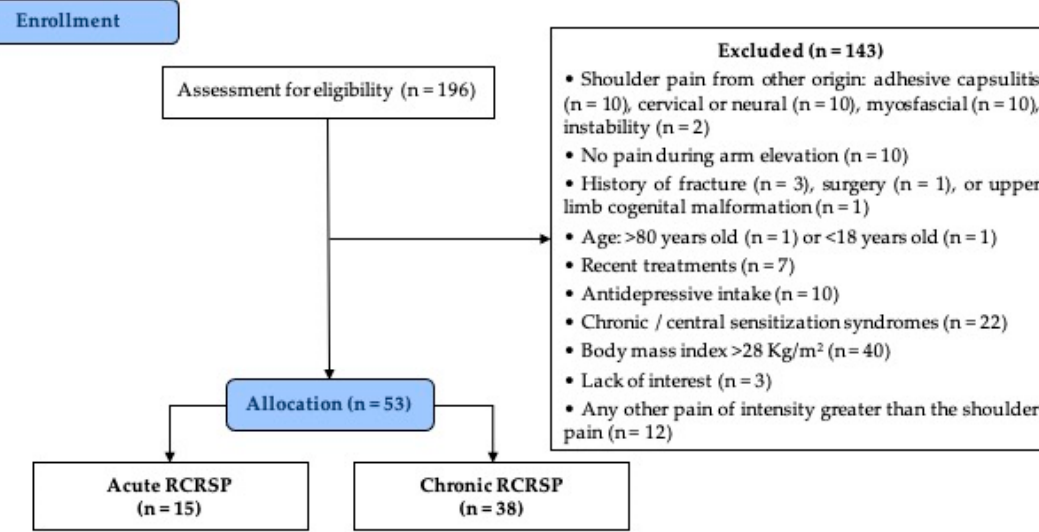
Figure 2. Flow diagram for enrollment and allocation of the participants.